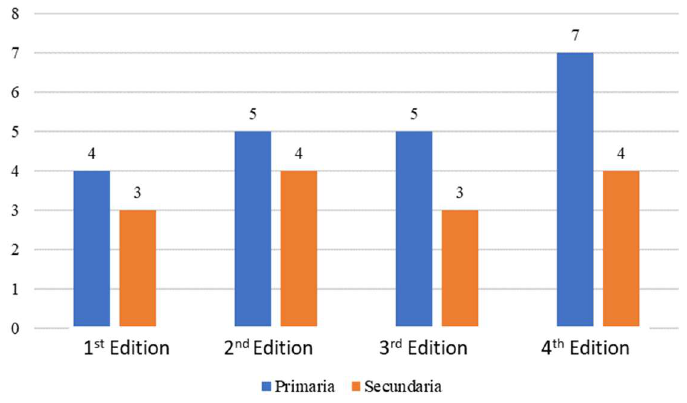
Figure 7. Primary and Secondary participants centres per Edition, Source: Own elaboration.